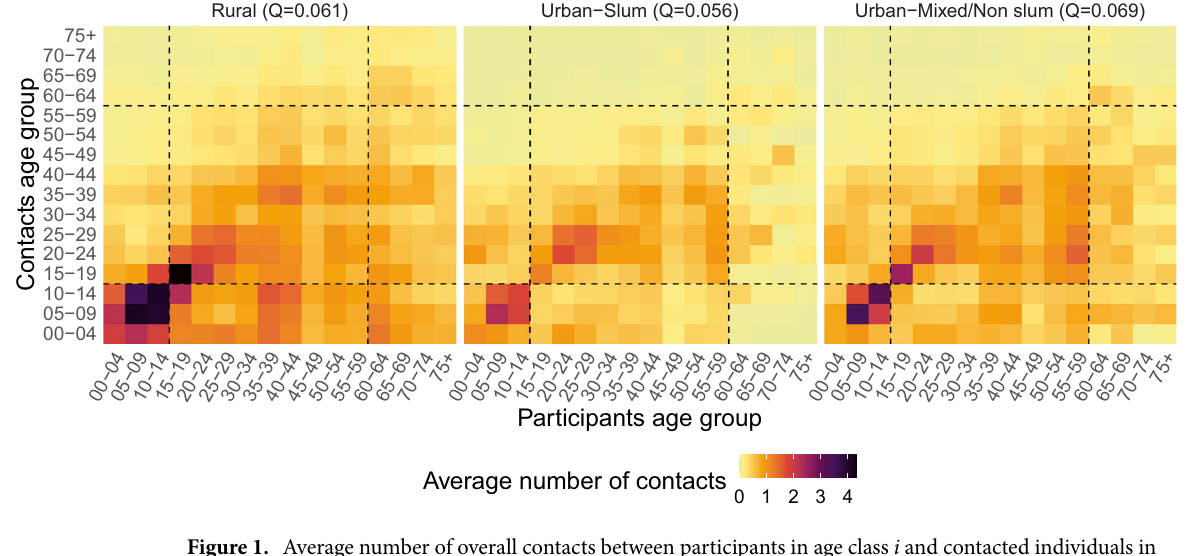
Figure 1. Average number of overall contacts between participants in age class i and contacted individuals in age class j , adjusting for reciprocity of contact at the population level, in each of the three settings. The dashed lines help identifying the contacts of children (0–14 years), teens and adults (15–59 years) and older adults (60+ years). At the top of each matrix, we report its assortativeness index